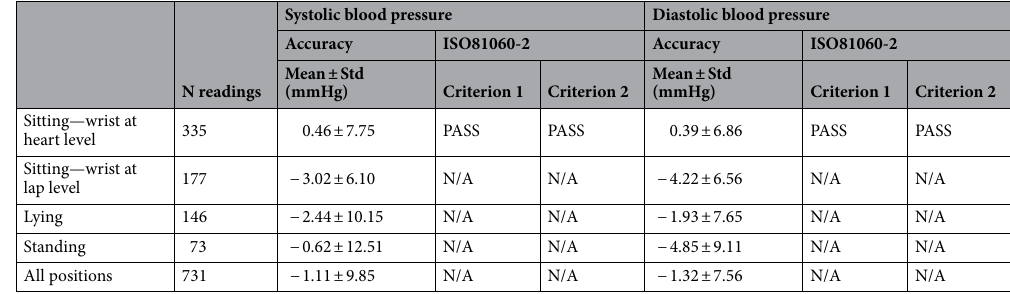
Table 2. Performance of the Aktiia Bracelet when compared against double auscultation for different body positions. Results depict mean and standard deviation of the differences between the two measuring modalities, and pass/fail criteria of ISO81060-2 when applicable 19 .